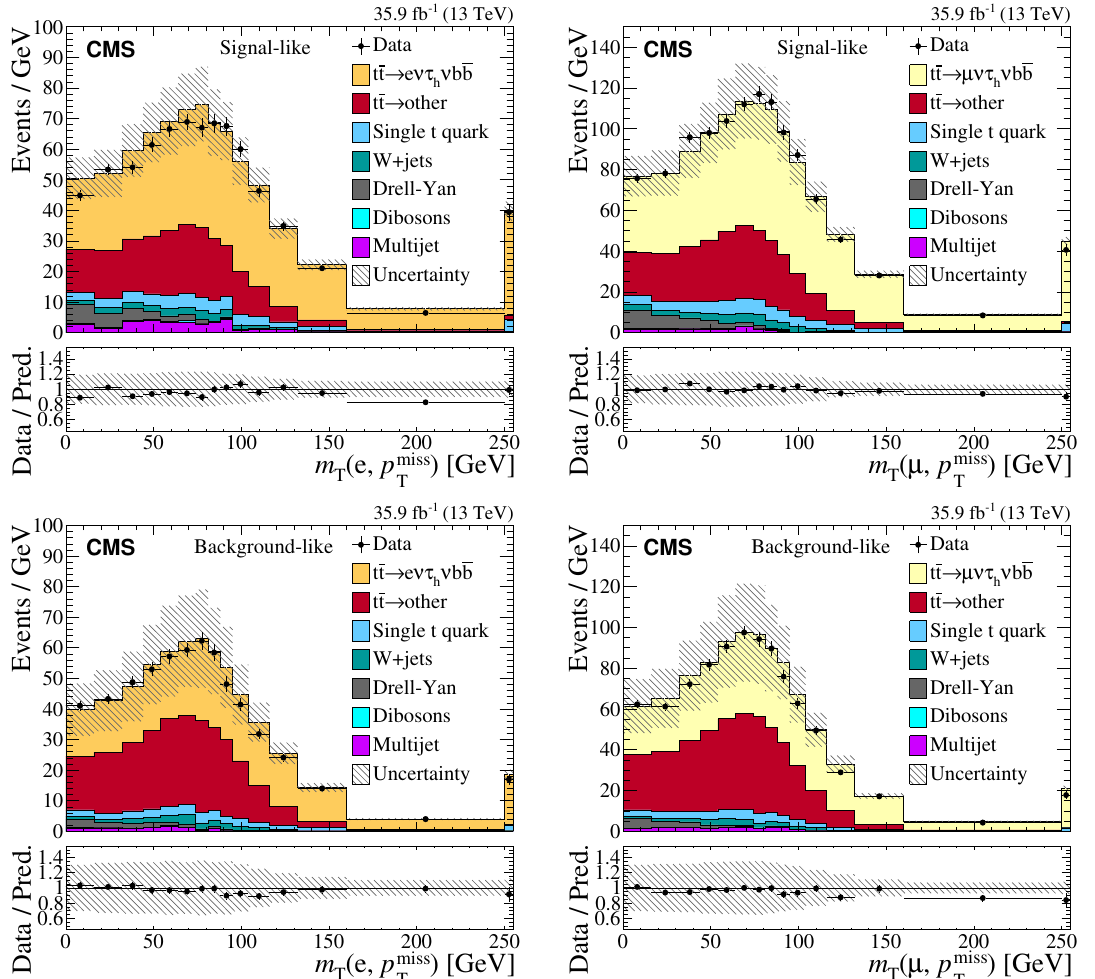
Figure 3. The transverse mass distributions between lepton (e or m ) and p miss like (upper) and background-like (lower) event categories for the e t states observed prior to (cid:12)tting. Distributions obtained from data ((cid:12)lled circles) are compared with simulation (shaded histograms). The last bin includes over(cid:13)ow events. The simulated contributions are normalized to the cross section values predicted in the SM. The main processes are shown: the signal, the other tt processes grouped together, single top quark production, W+jets, DY processes, diboson, and multijet production. The ratio of the data to the total SM prediction is shown in the lower panel. The vertical bars on the data points indicate the statistical uncertainties, the hatched band indicates the systematic uncertainties and the statistical uncertainties in all simulated samples.